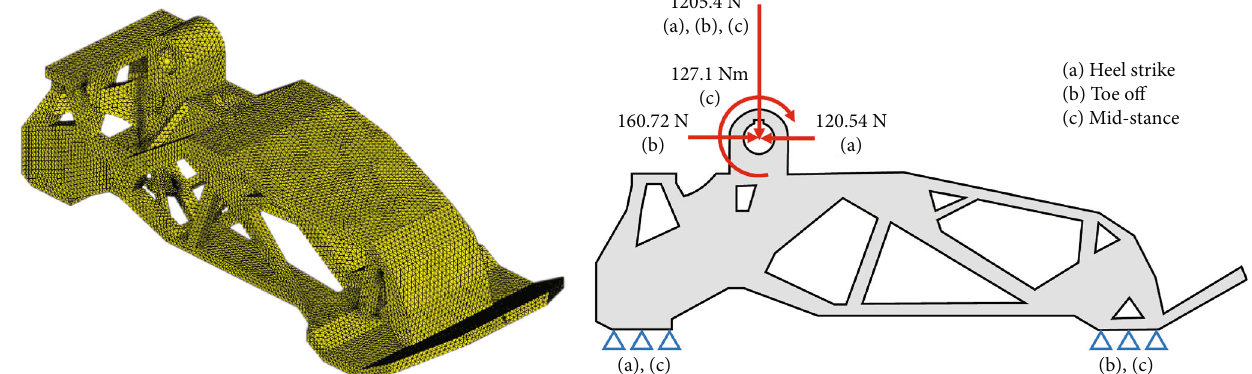
Figure 13: A 3D mesh of the foot structure and the boundary conditions.